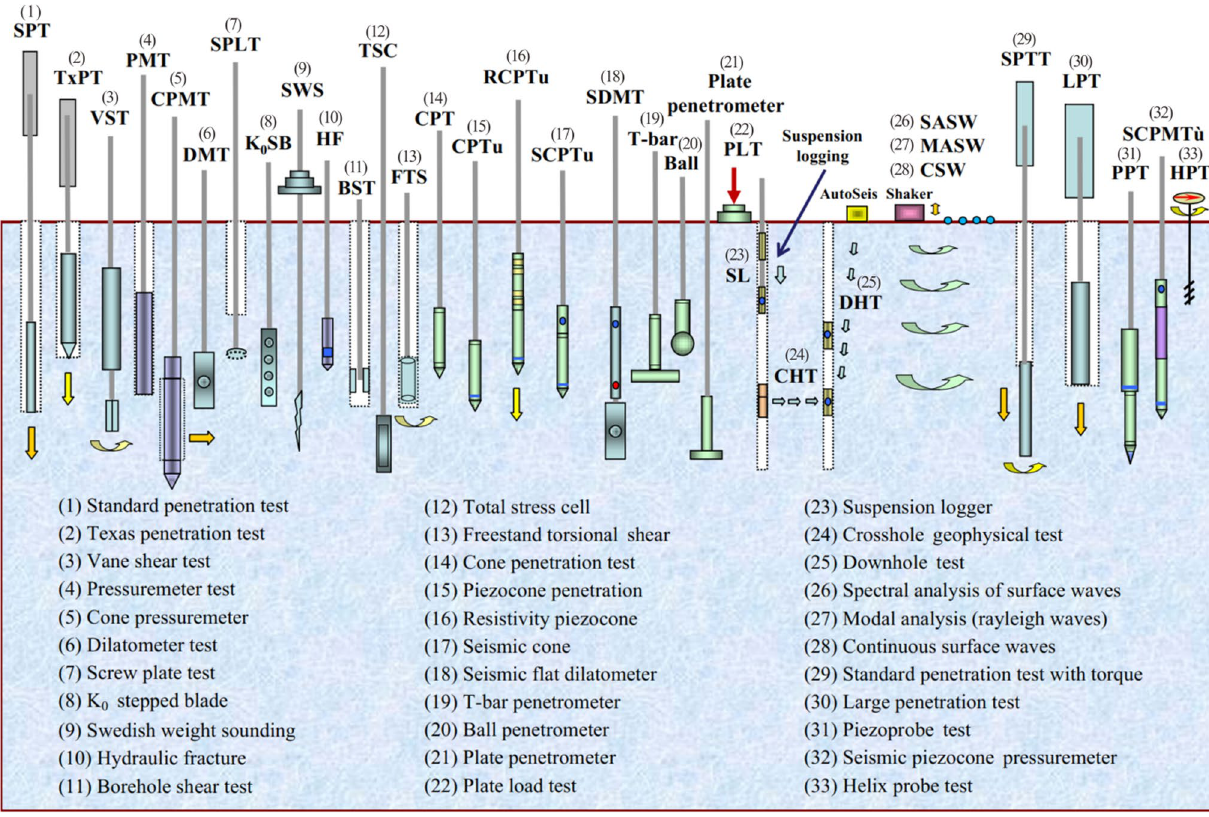
Fig. 11 Common in-situ testing techniques (modified from Mayne et al.